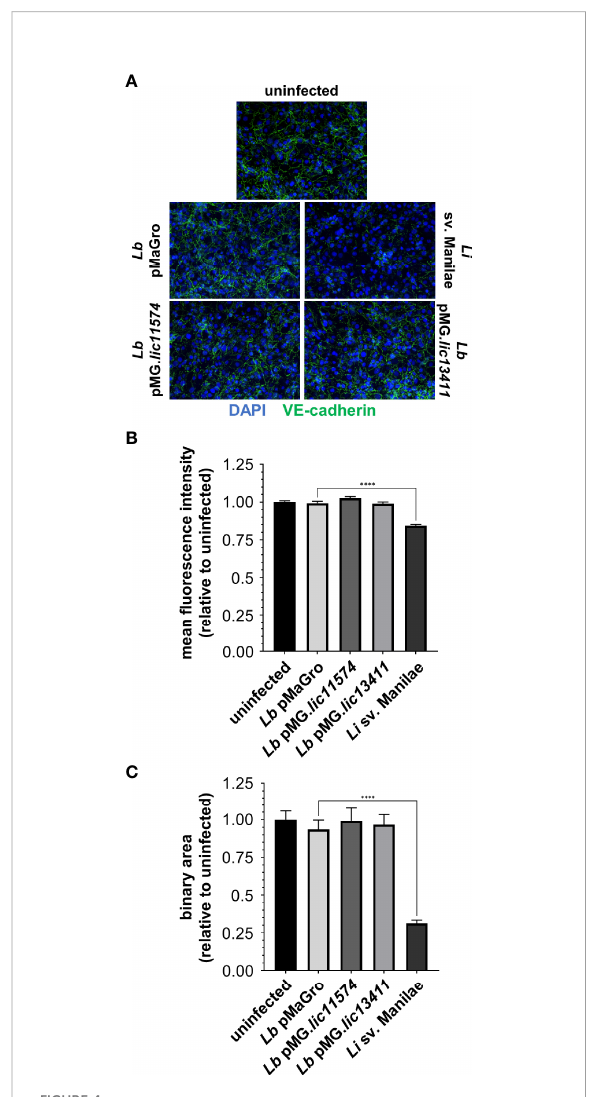
FIGURE 4 L. bi fl exa producing LIC11574 and LIC13411 do not disrupt VE- cadherin staining. HMECs were grown to con fl uence on glass coverslips and infected at an MOI of 20 for 24 h. Cells were fi xed, stained for VE-cadherin (green), and mounted with Prolong Diamond Antifade Mountant with DAPI (blue). (A) Representative images are shown highlighting the change in VE-cadherin staining upon infection with various strains of Leptospira spp. Pathogenic Leptospira disrupts VE-cadherin localized in AJs, whereas the non- pathogen and GOF strains do not. (B, C) M.f.i. and binary area were quanti fi ed. No change in total VE-cadherin or VE-cadherin associated with AJs is seen upon treatment with non-pathogenic or GOF strains, whereas pathogenic Leptospira disrupt VE- cadherin localization. Data represent two independent experiments; 10 images per slide were taken and analyzed quantitatively for each experiment. Mean ± SEM is plotted. Each column is compared to the L. bi fl exa pMaGro control. **** denotes p ≤